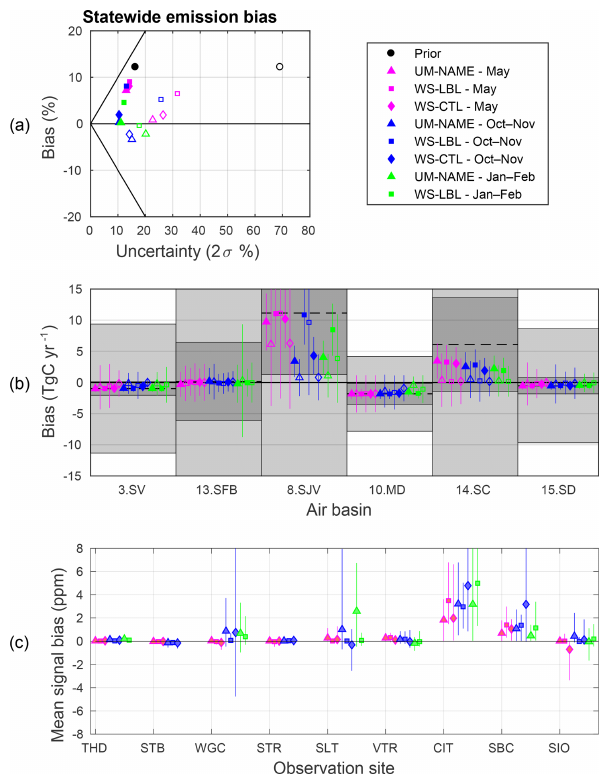
Figure 3. (a) Statewide and (b) individual air basin inversion results for an error in the magnitude of prior emissions. Prior emissions are given by EDGAR, and true emissions are given by EDGAR scaled to Vulcan total in each air basin. Air basin results are shown for Sacramento Valley (3.SV), San Francisco Bay (13.SFB), San Joaquin Valley (8.SJV), Mojave Desert (10.MD), South Coast (14.SC), and San Diego (15.SD). Prior results are presented by black markers, and posterior results are represented by coloured markers. Filled markers show results using SD prior uncertainty, and empty markers show results using 70% prior uncertainty. The prior bias in each air basin is given by the dashed lines in (b) , with SD prior uncertainty (dark grey) and 70% prior uncertainty (light grey). Prior and posterior uncertainties are expressed as 2 σ . The bottom plot (c) shows the mean signal error in simulated average ffCO 2 concentration. Mean signal error is calculated by subtracting the average true signal from the average prior signal. Error lines are drawn between the maximum and minimum signal bias per cam- paign.